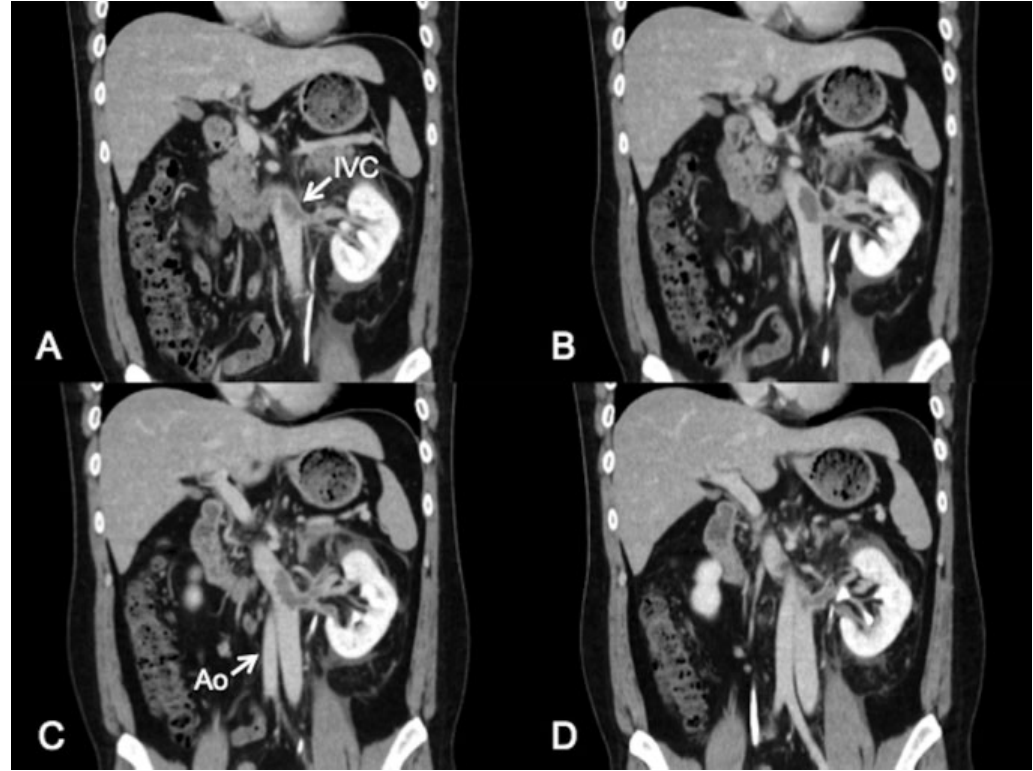
Fig. 2 ( A – D ) Coronal view of contrast-enhanced computed tomography from abdominal to dorsal. Giant thrombus appears in left inferior vena cava and left renal vein distal to the crossover